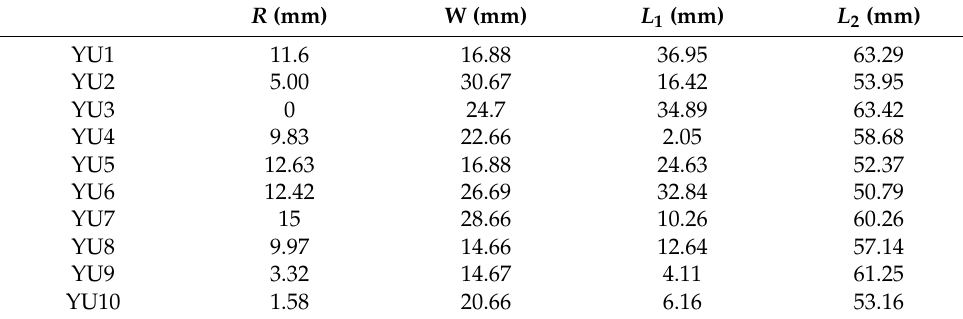
Table 2. Optimal Latin hypercube design of